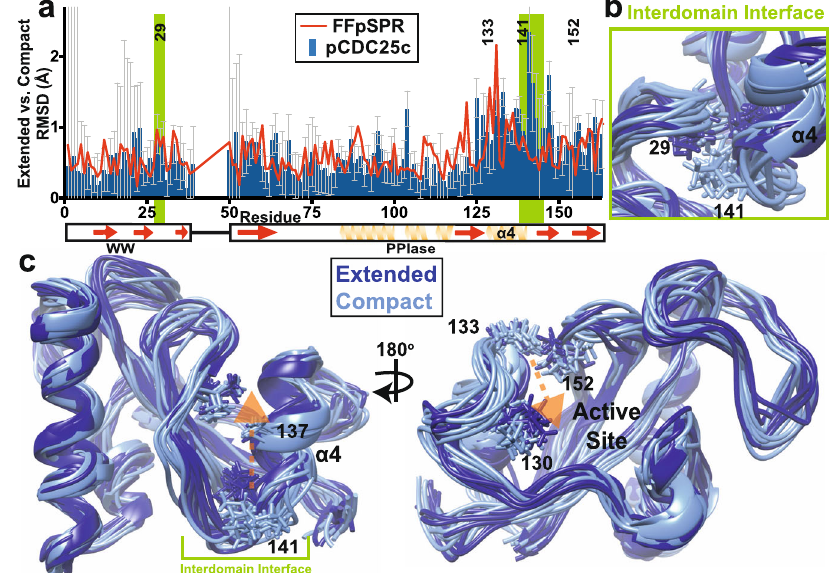
Fig.4|Couplingofinter-andintradomainspatialsamplingofpCDC25c-bound Pin1. The two-state ensemble is analyzed with the states sorted by presence or absence of interdomain contact (compact or extended state, respectively). a For the pCDC25c-bound ensemble, RMSD (including side-chain) between mean com- pactand extended statesofdomains isplotted inblue versusresidue number.The error bars depict the square root of the sum of the squared variances for the compactandextendedstatesalone,providinganupperlimitfortheuncertaintyof the mean difference between the mean compact and extended states. The RMSD